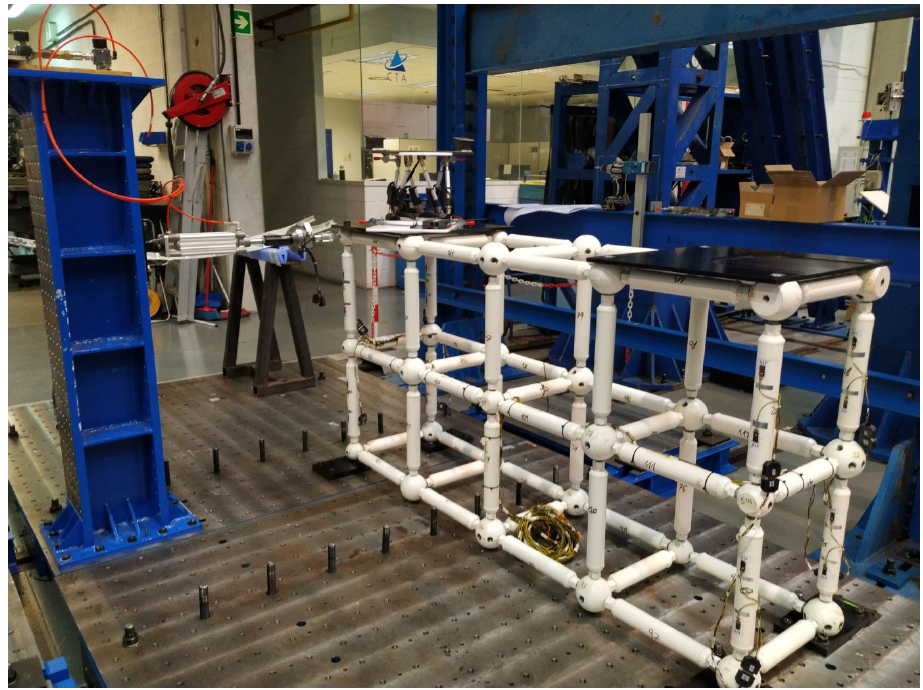
Figure 13. Aeronautical reconfigurable tooling prototype based on bar-knot structure in which the monitoring system was tested.